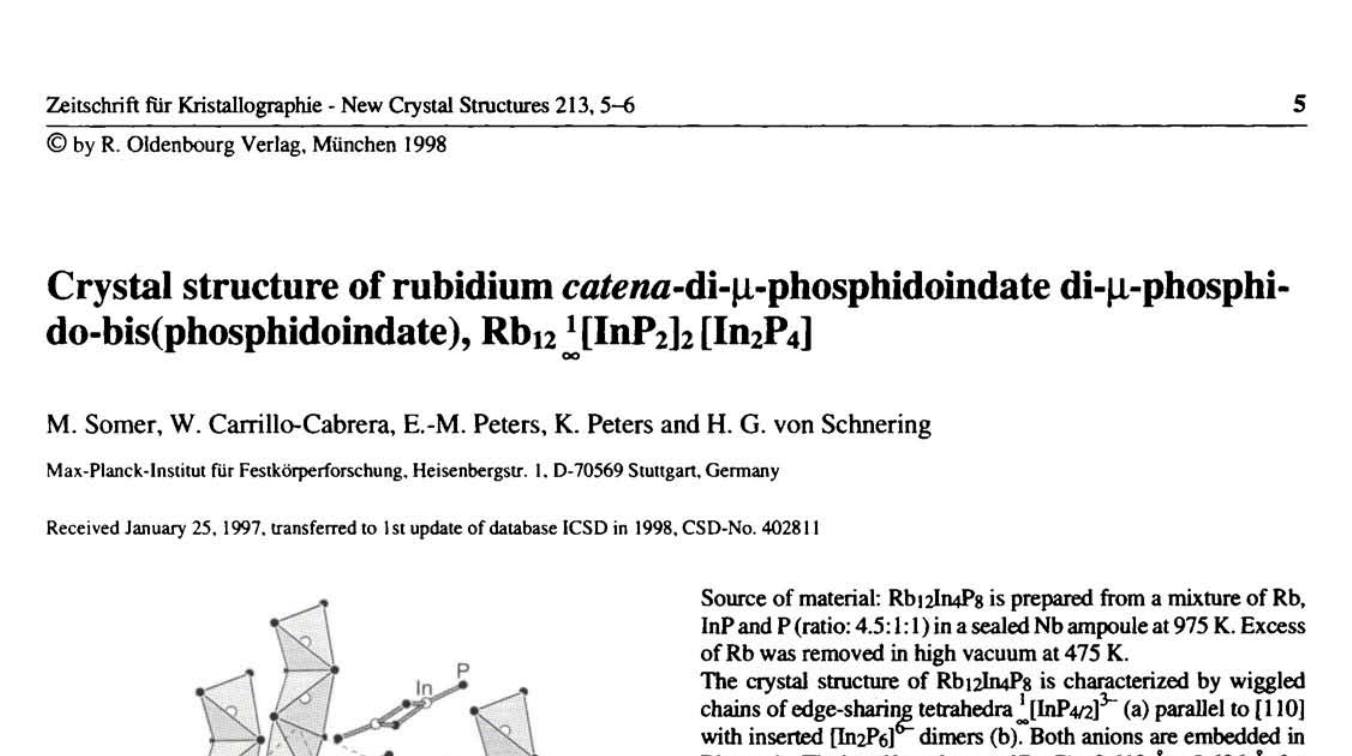
Table 1. Parameters used for the X-ray data collection Crystal: Wavelength: